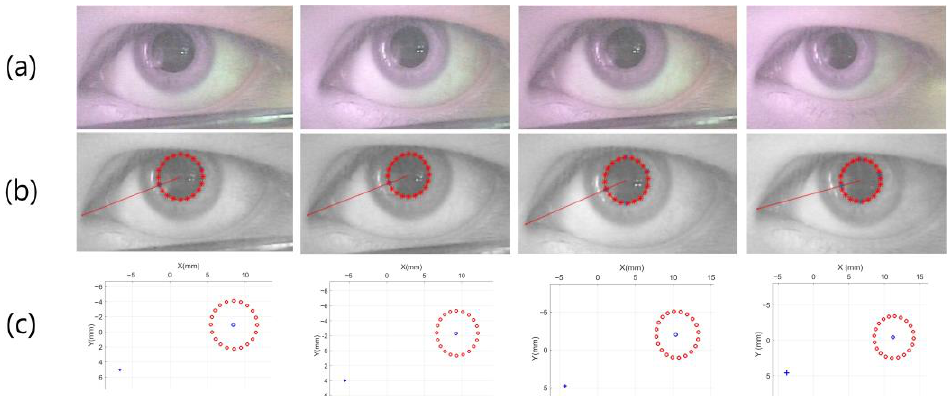
Figure 5. ( a ) represents the change of the pupil size when watching objects at different distances; ( b ) represents the extraction of the pupil and inner eye corner; and ( c ) shows the spatial coordinates of the inner eye corner and pupil edge.